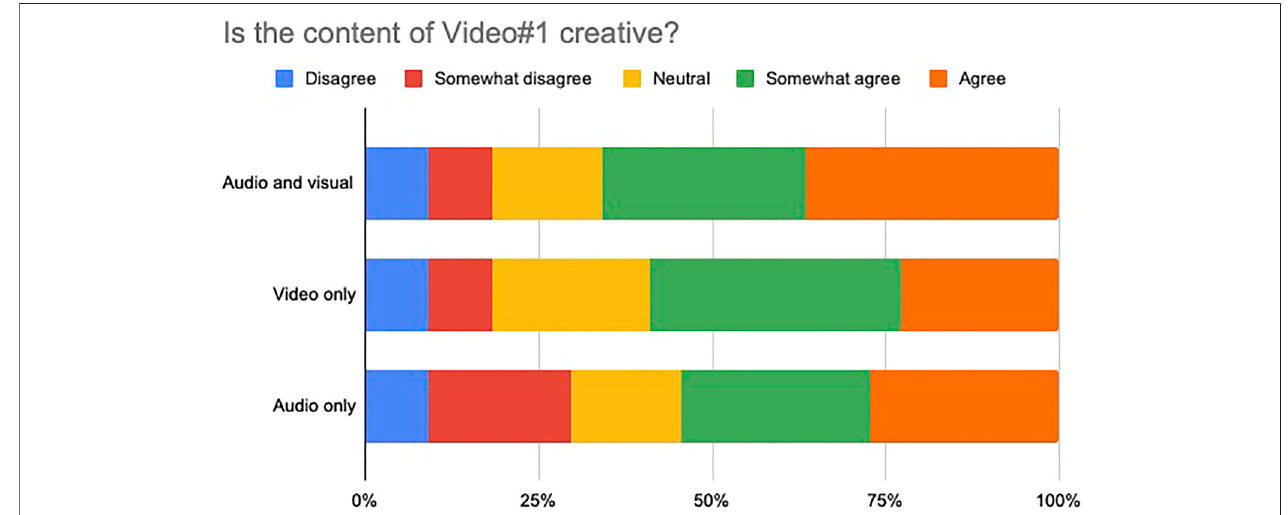
FIGURE 11 | Perceptual evaluation of Video #1. Forty-four participants responded the survey over the internet. All three type of contents: audiovisual, visual only and audio only, were judged to be creative by a great majority of participants.